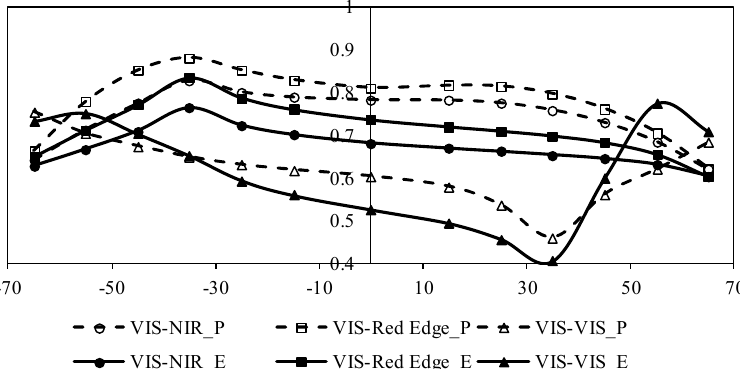
Figure 9. Average R 2 of the linear relationships between LAI and NDSIs in the VIS-VIS, VIS-Red-edge, and VIS-NIR regions at different VZAs in PP for the erectophile (solid line, VIS-VIS_E, VIS-red-edge_E, VIS-NIR_E) and planophile varieties (dotted line, VIS-VIS_P, VIS-Red-edge_P, VIS-NIR_P) based on PROSAIL simulations.